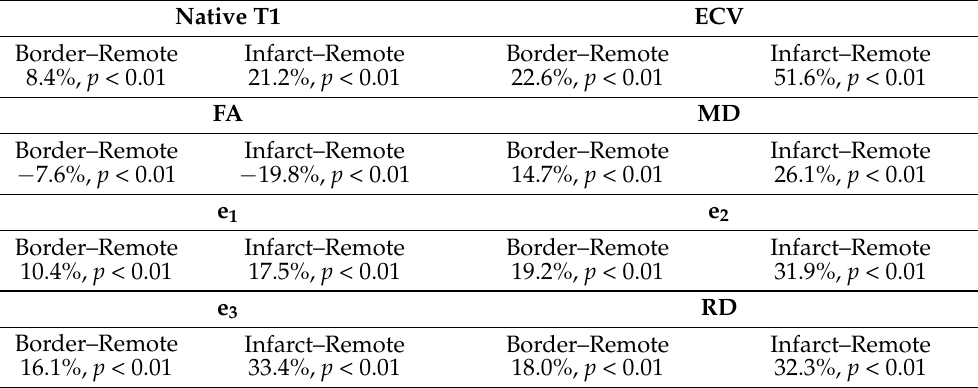
Table 2. Overall percentage change in median values and resulting p -values from non-parametric pairwise Kruskal–Wallis test for native T1, ECV, FA, MD, diffusion tensor eigenvalues, and RD between border–remote and infarct–remote regions across all subjects.